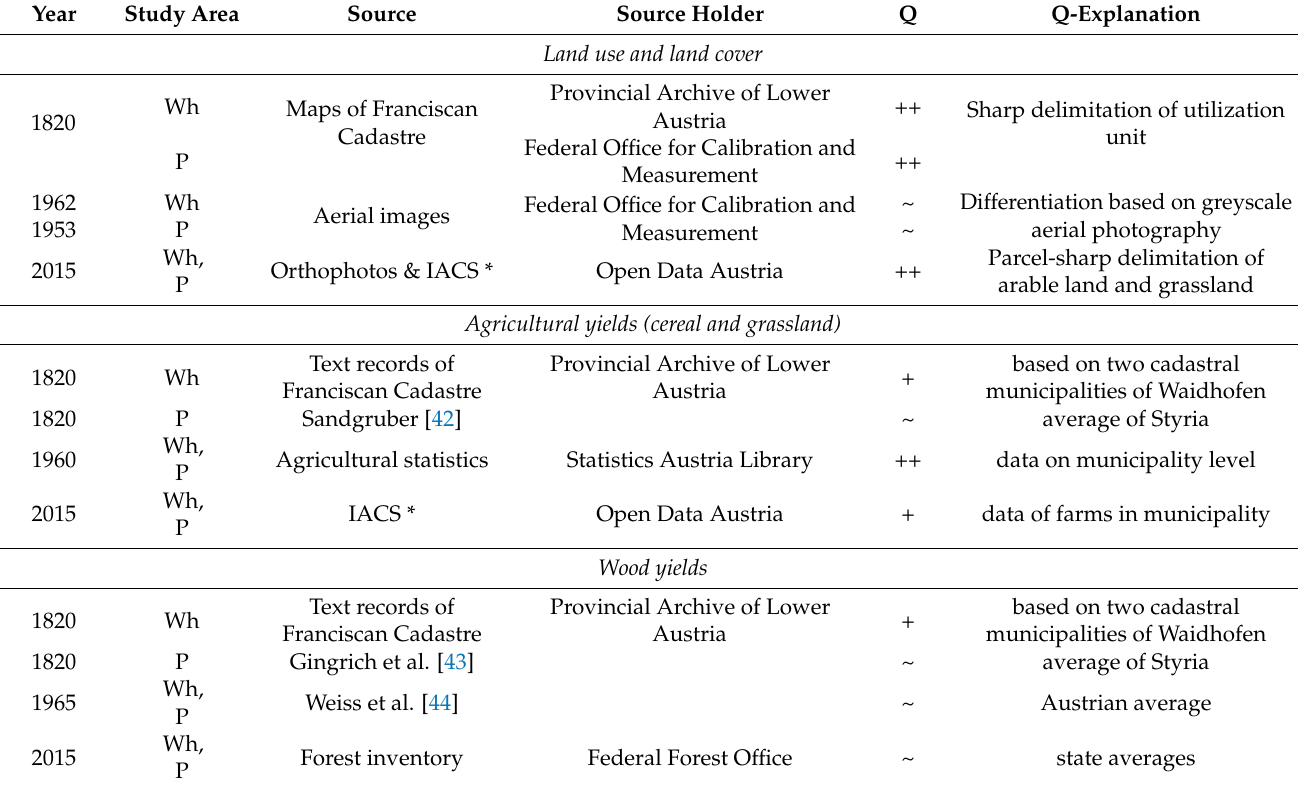
Table 1. Sources of land use legacy information of at least acceptable spatial and thematic quality identified for the case study